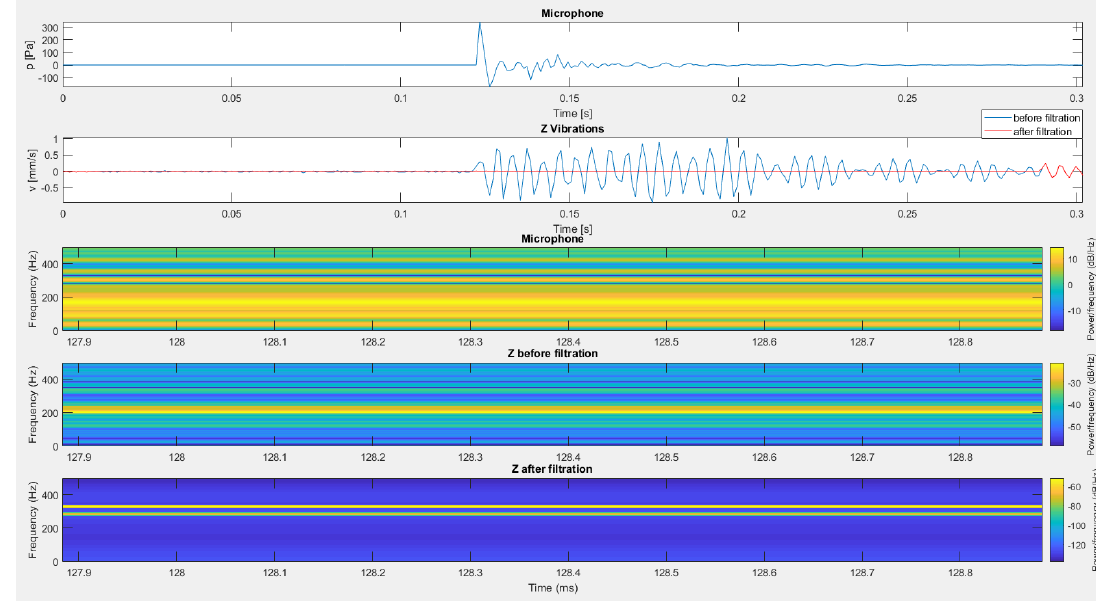
Figure 17. The result of using filtration for the vertical component from a sensor placed inside the building—an internal microphone.